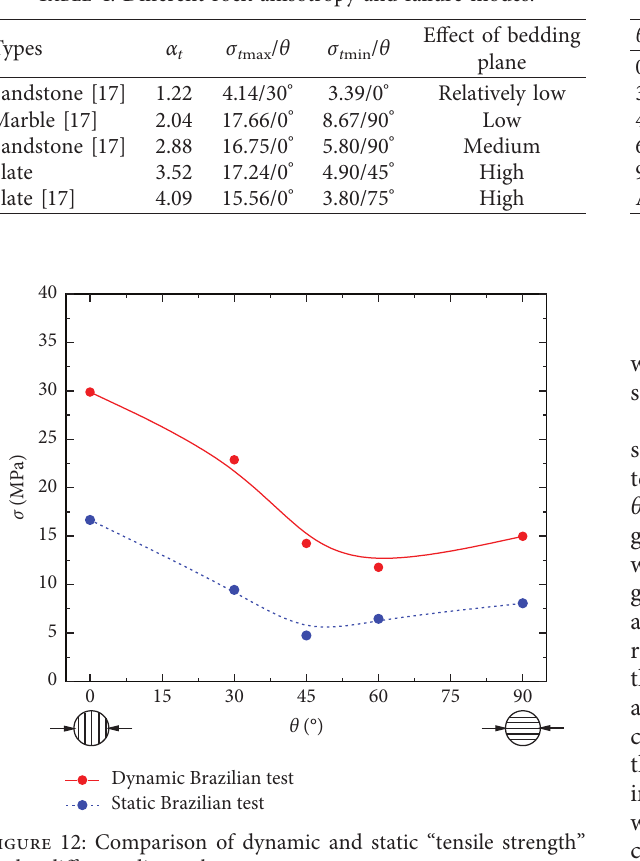
Figure 11: Failure mode of sandstone with dip angles of 15 ° , 45 ° , and 90 ° [10]. Table 4: Different rock anisotropy and failure modes. Table 5: Dynamic “tensile strength” DIF value of the